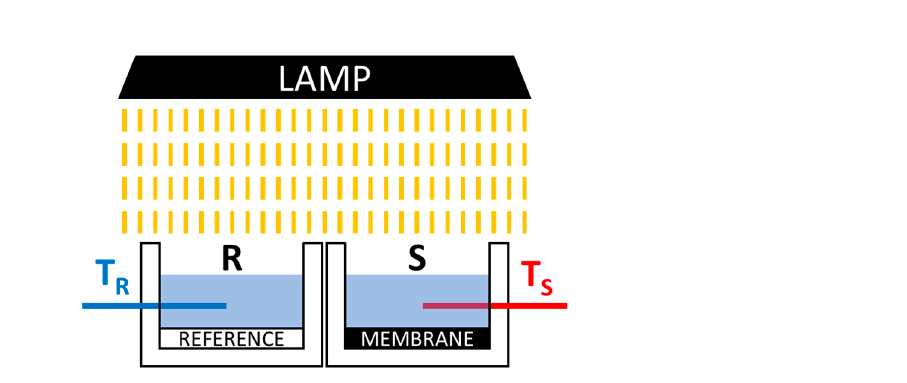
Figure 1. Sketch of the setup for membrane photothermal tests. T R : reference thermocouple; T S : sample thermocouple.